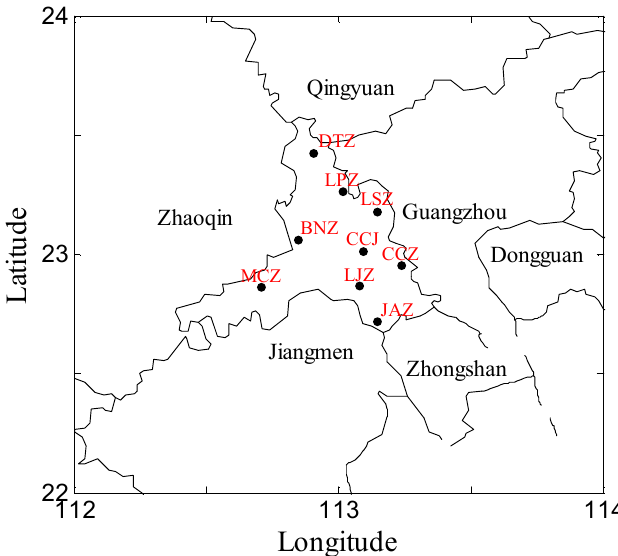
Figure 1. Geographical distribution of the Foshan Total Lightning Location System (FTLLS), in which a full operation of nine sub-stations in the Foshan area were shown. Sub-station location is indicated by a black dot.